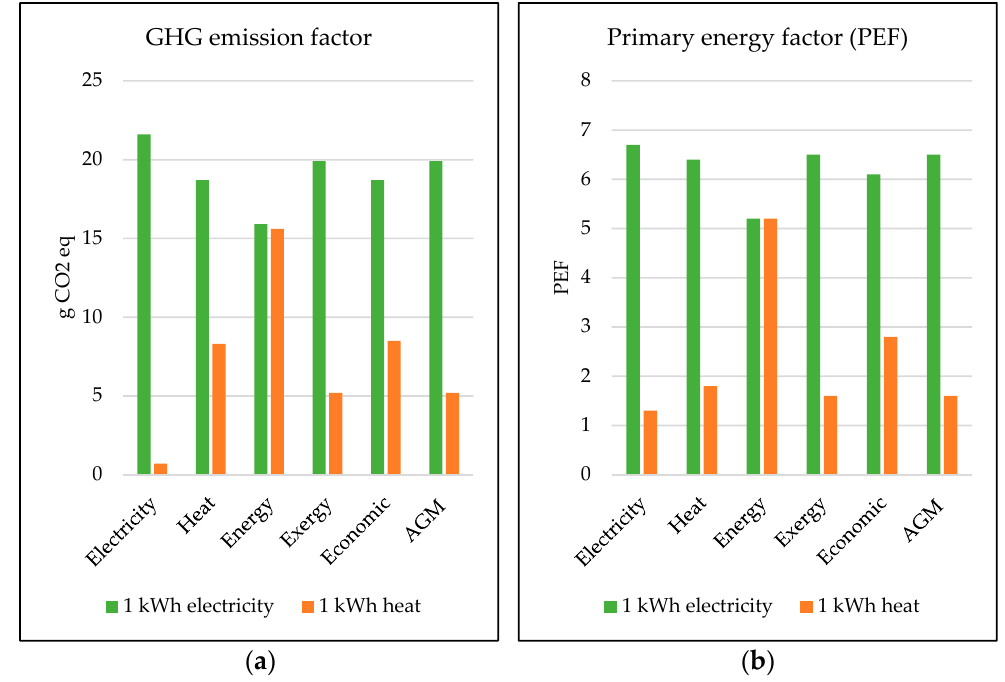
Figure 5. The results of the two indicators for GHG emissions and PEF vary greatly due to different allocation methods used to allocate impacts between the production of electricity and heat: ( a ) Results for the GHG emission factor for electricity and heat for the different allocation methods analyzed in the study; ( b ) The total primary energy factor shows the sum of all renewable and non-renewable energy inputs needed to produce 1 kWh of electricity or 1 kWh of heat.